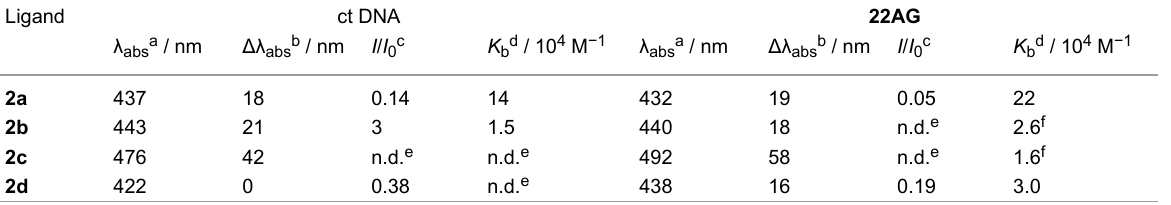
Table 3: Absorption and emission properties of ligands 2a–d upon the addition of DNA, and binding constants K b . Ligand ct